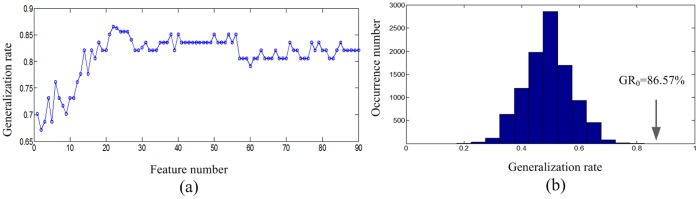
Performance evaluation of the LDA+SVM classifier.(a) The curve of the generalization rate to the number of features. (b) Permutation distribution of the estimate (repetition times: 10,000). GR0 is the generation rate obtained by the classifier trained on the real class labels. With the generalization rate statistic, this figure reveals that the classifier learned the relationship between the data and the labels with a probability of being wrong of <0.0001.